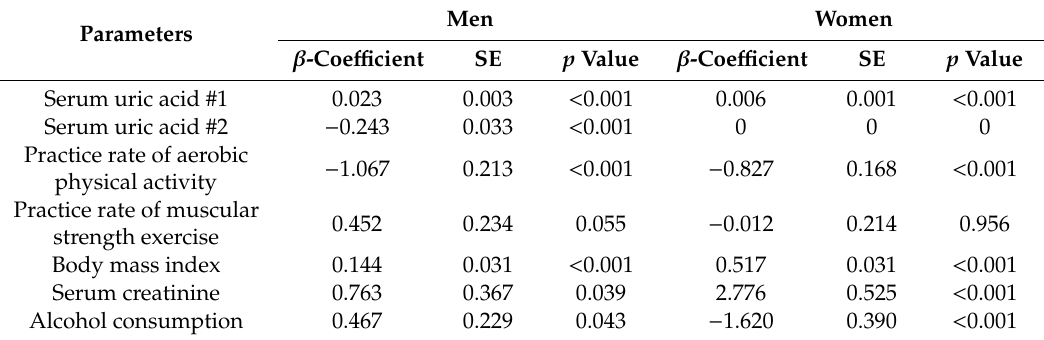
Table 2. Associations of serum uric acid and covariates with cardiovascular disease risk.